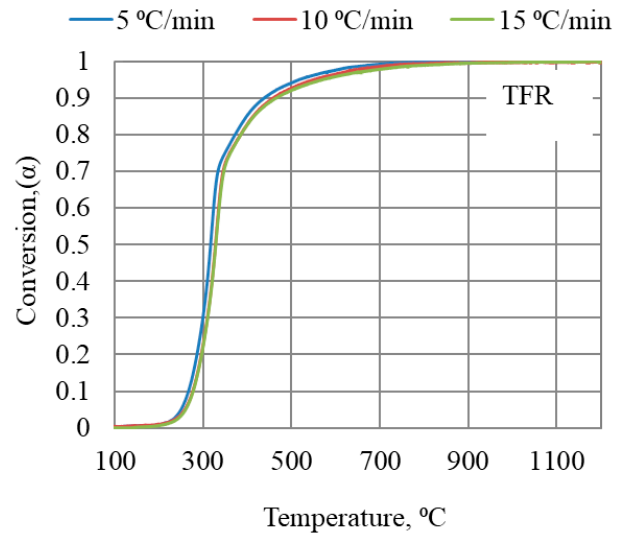
Figure 4. Conversion degrees for torrefied forest residue as a function of temperature in TGA at three heating rates up to 1200 °C.